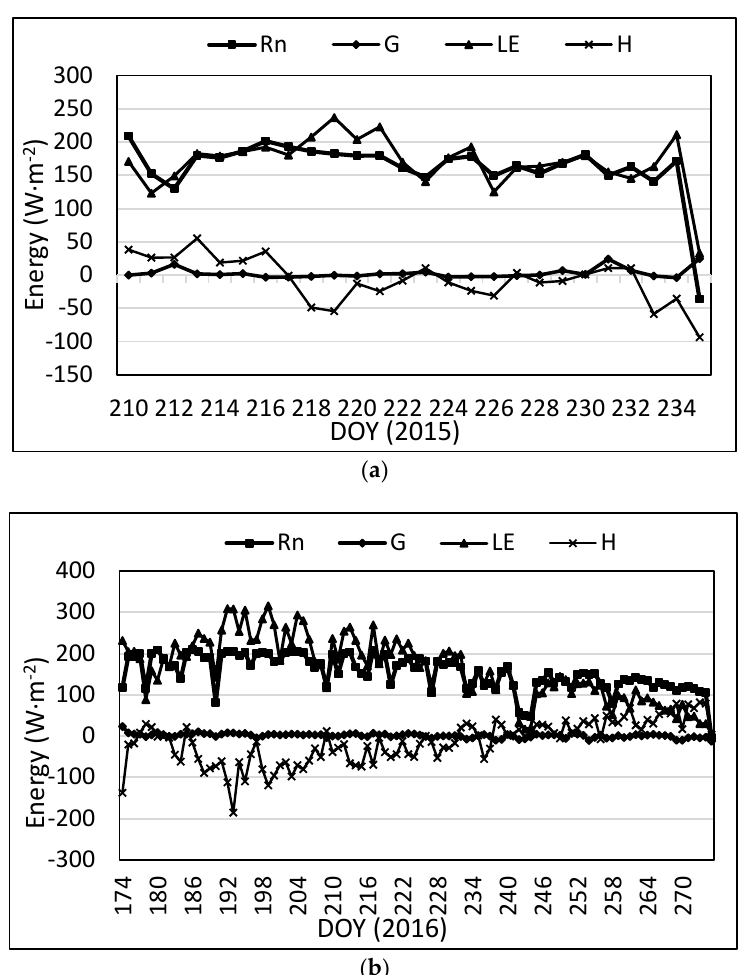
Figure 4. Average daily energy balance components on the lysimeter for ( a ) 2015; ( b ) 2016.